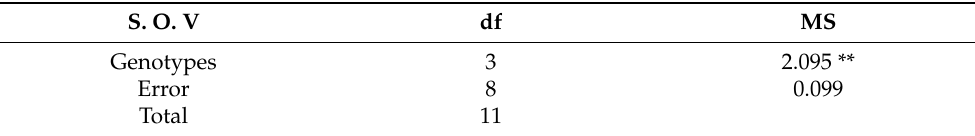
Table 6. Analysis of variance of nuclear DNA content in P. vulgaris L. genotypes.